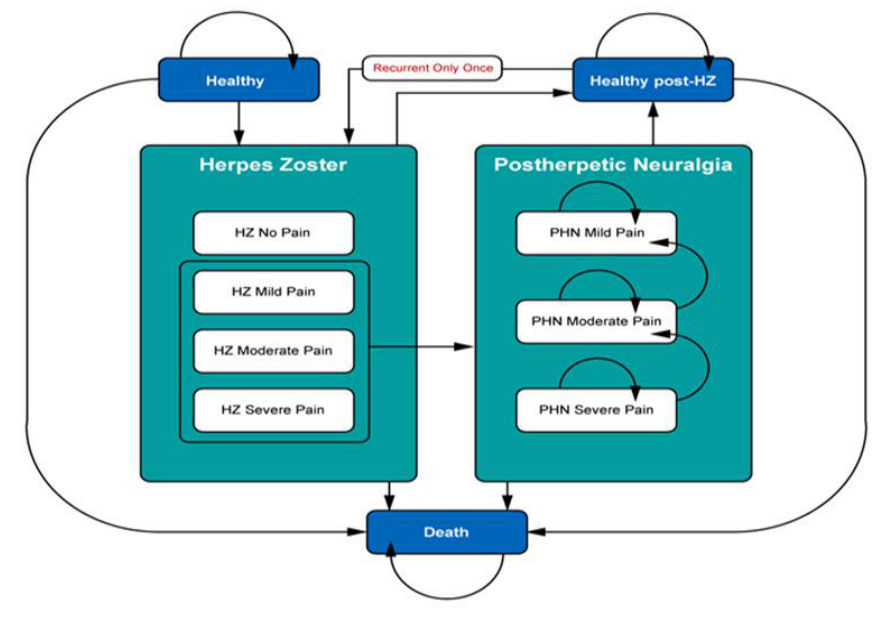
Figure 1: Markov model structure and health